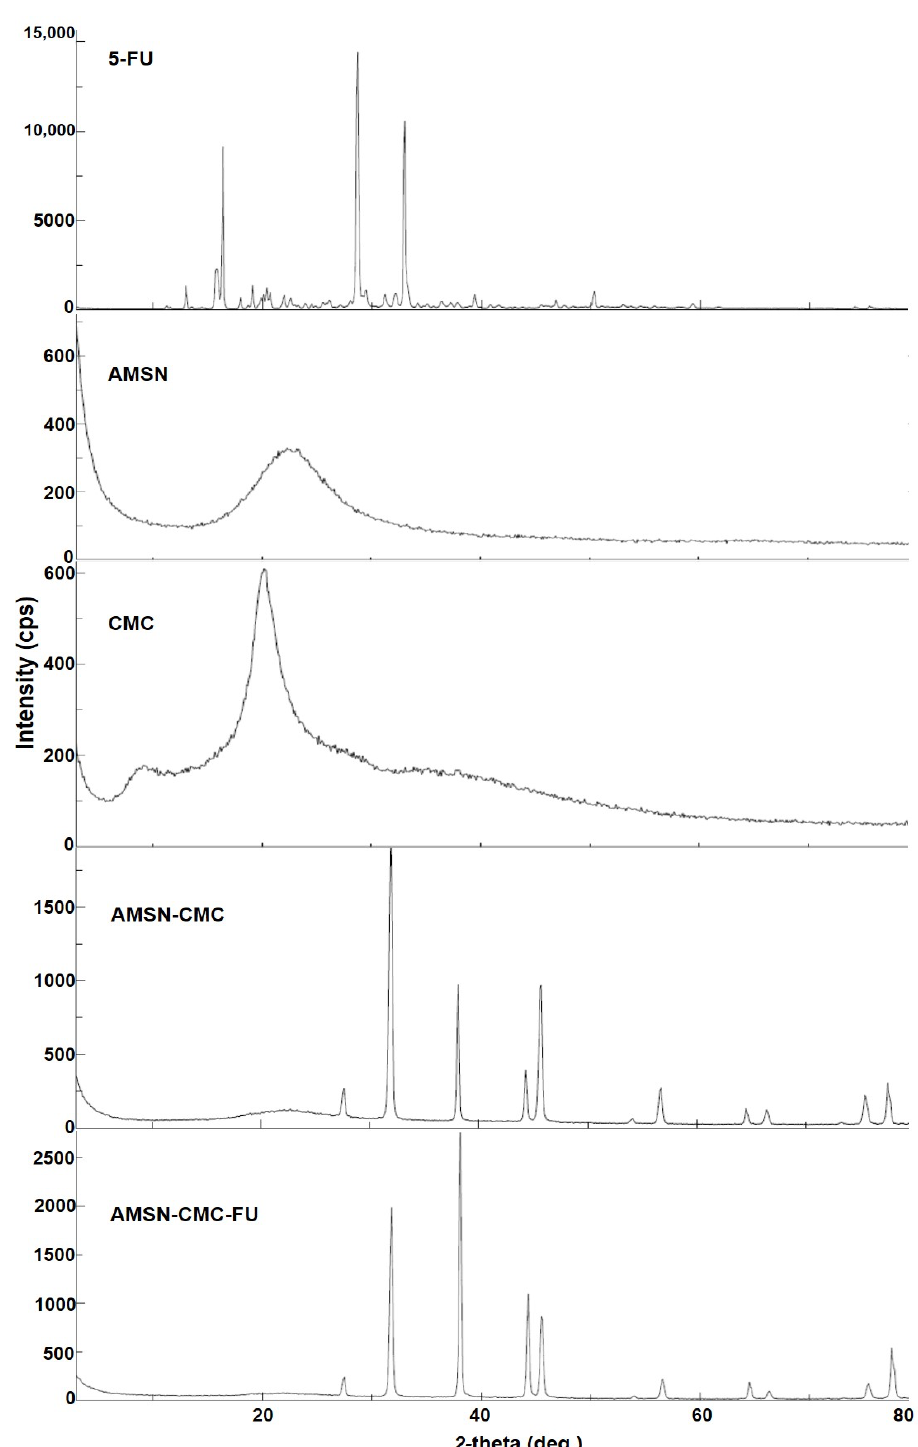
Figure 5. Powder X-ray diffraction patterns (PXRD) of 5-FU, AMSN, CMC, AMSN-CMC, and AMSN-CMC-FU.